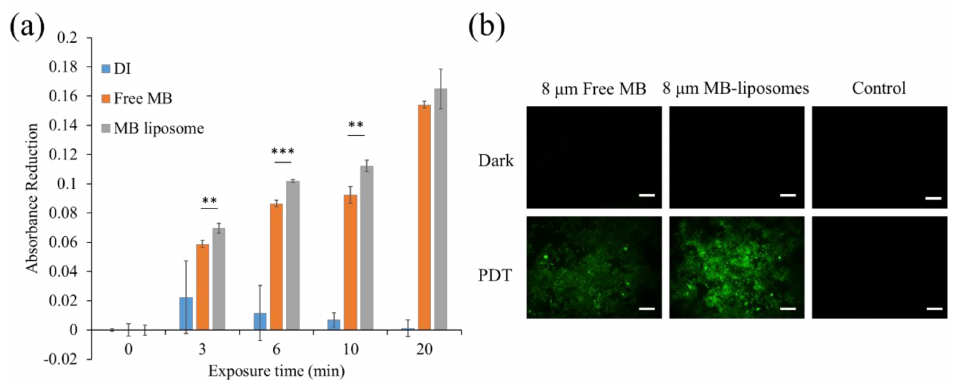
Figure 3. ( a ) N , N -dimethyl-4-nitrosoaniline (RNO) absorbance reduction at 440 nm of free MB and MB-liposomes after different irradiation time ( n = 4, **: p < 0.01, ***: p < 0.001 comparison between free MB and MB liposome at the same exposure time); ( b ) fluorescence images of 2 (cid:48) ,7 (cid:48) -dichlorofluorescein diacetate (DCFH-DA) assay of free MB and MB-liposomes. Green, 2 (cid:48) ,7 (cid:48) -dichlorofluorescein (DCF); Scale bar, 200 µ m.